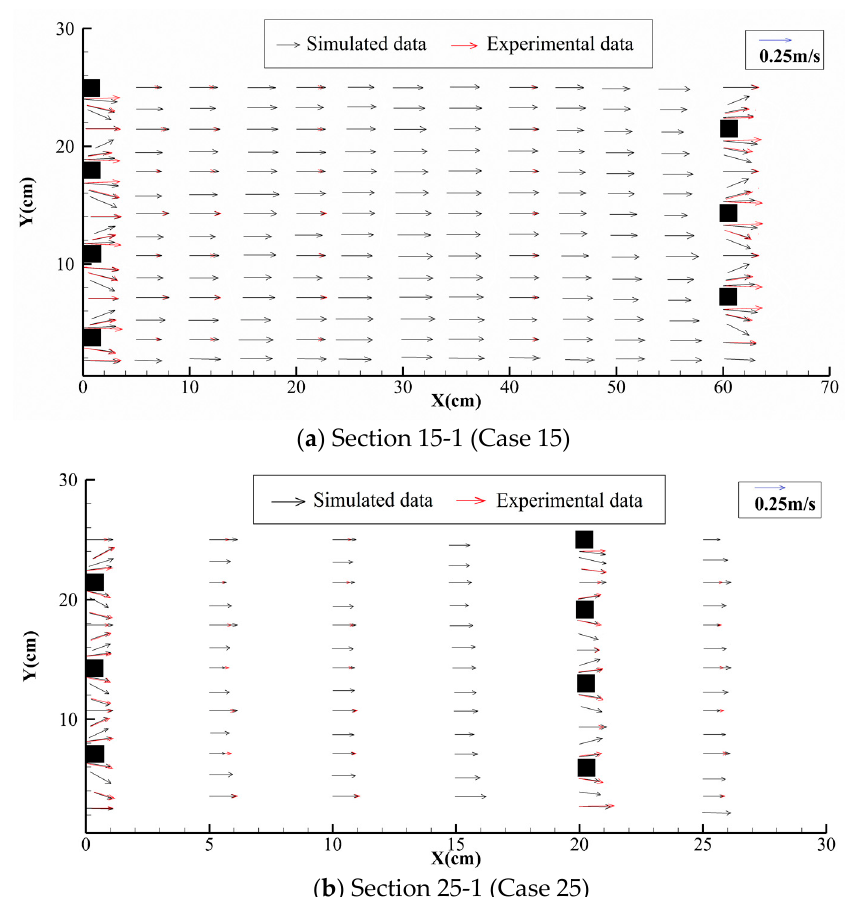
Figure 6. Distribution of the simulated results and experimental results of the surface velocity vector.